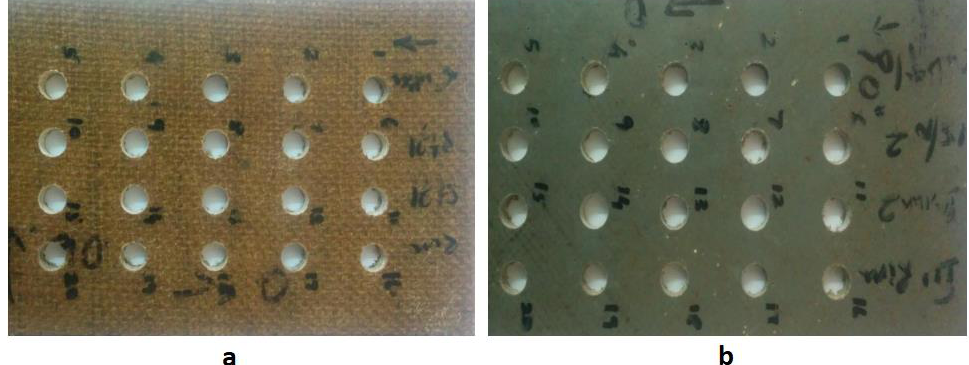
Figure 6. Holes drilled in jute/sisal hybrid composites: ( a ) without SiC filler; ( b ) with SiC filler [98]. Prakash et al. used a hand layup technique to fabricate a basalt/cashew nutshell liq- uid (CNSL)/epoxy resin composite mixed with equal amounts of SiC and banana fiber particulates (BNP), respectively. Laminates with a central hole of 6 mm in diameter and without a hole were subjected to tensile tests. Consequently, the authors reported 20% and 35% losses in tensile strength for the basalt/CNSL/epoxy/BNP laminate and Bas- alt/CNSL/epoxy/SiC laminate with holes compared to the specimens without holes. Among the investigated laminates, the composite with SiC filler presented superior ten- sile strength and a better retention of tensile strength with an open hole. The fillers were also found to influence the failure under tension for the notched laminates. The bas- alt/CNSL/epoxy/BNP laminate showed typical failures such as fiber breakage and cracks that were initiated around the vicinity of the hole and propagated along the width per- pendicular to the applied load. In contrast, crack growth initiated around the hole and propagated along the length of the Basalt/CNSL/epoxy/SiC laminate [99]. 3.2.3. Fiber Surface Modification and Use of Coupling Agents To improve the compatibility between the polymer matrix and natural fibers, vari- ous fiber pre-treatment techniques, such as alkylation, acetylation, and the use of a cou- pling agent, namely, maleic anhydride (MA), can be employed [100]. Fiber pre-treatment is used to improve a composite’s mechanical properties by modifying the fiber surface via the removal of fiber constituents, such as hemicellulose, pectin, lignin, and other im- purities, such that the modified fiber surface more effectively promotes mechanical in- terlocking between the natural fibers and the polymer matrix. In the specific case of ma- leic anhydride, the wettability between the polymer and matrix improves via grafting, in which the coupling agent forms covalent bonds with the polymer and fiber [101]. In their study, Kannan et al. incorporated MA into a PP matrix and investigated the open-hole-related tensile properties of a flax/PP laminate. The strength retention charac- teristics under a tensile load did not improve for the laminates with open holes, while the undrilled laminates infused with MA exhibited superior tensile strength and stiff- ness compared to the undrilled laminates without MA [102]. There are hardly any studies on the use of fiber pre-treatments and coupling agents, specifically in the polymer matrix, on the RTS of biocomposites. The mechanism behind the strength retention characteristics also needs to be addressed.